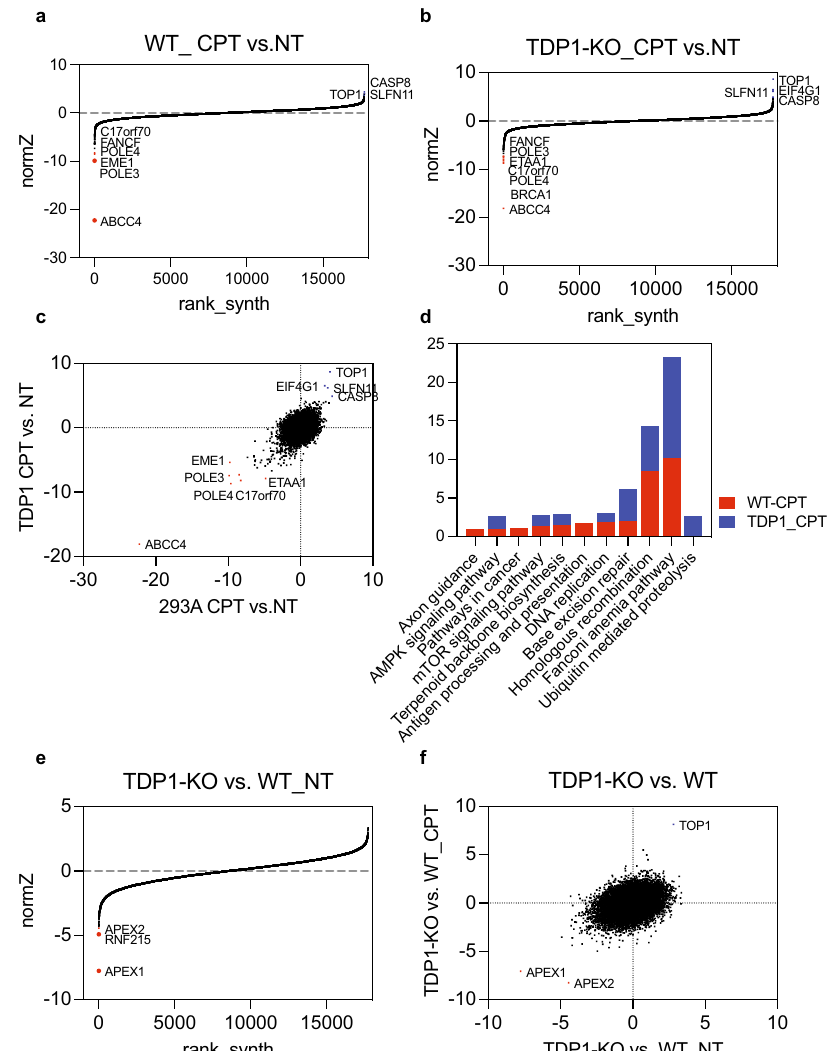
Fig. 4 Genome-wide CRISPR/Cas9 screens in WT and TDP1-KO cells with TOP1 poison. a Ranking of CPT co-essential genes on the basis of drug Z analysis of the results of CRISPR/Cas9-based screening in HEK293A-WT cells. The z-score was used to de fi ne a possible synthetic lethal interaction with CPT. All genes targeted by the Toronto Knock Out Library v3 were scored according to the fold change of levels of their sgRNAs. The CPT-treated group and not treated (NT) group in WT cells were compared. Genes whose loss of function led to CPT sensitivity appear on the left side, with a minus Z score, and genes whose loss of function led to CPT resistance appear on the right side, with a positive Z score. Top-ranked genes on either side are marked. b Ranking of CPT co-essential genes on the basis of a drug Z analysis of the results of CRISPR/Cas9-based screening in TDP1-KO cells. Data were analyzed and presented as in a . The CPT-treated group and NT group in TDP1-KO cells were compared. c Combinational comparison of CPT co-essential genes between HEK293A-WT and TDP1-KO cells. The z-scores from a , b were used. d A p value is calculated from the normZ and corrected for multiple hypothesis testing using the method of Benjamini and Hochberg. KEGG pathway analysis of genes whose loss of function led to CPT sensitivity ( p < 0.01) in WT and TDP1-KO cells was performed with DAVID Bioinformatics Resources 6.8, NIAID/NIH (https://david.ncifcrf.gov/summary.jsp). e Ranking of TDP1 co-essential genes on the basis of a drug Z analysis of the results of CRISPR-/Cas9-based screening. The z-score was used to de fi ne a possible synthetic lethal interaction with TDP1. All genes targeted by the Toronto Knock Out Library v3 were scored according to the fold change of their sgRNA levels. The NT TDP1-KO cell group and NT WT cell group were compared. f A combinational comparison was performed of TDP1 co-essential genes between HEK293A-WT and TDP1-KO cells using the z-score of the NT TDP1-KO cell group compared to the NT WT group and the CPT-treated TDP1-KO group compared to the CPT-treated WT